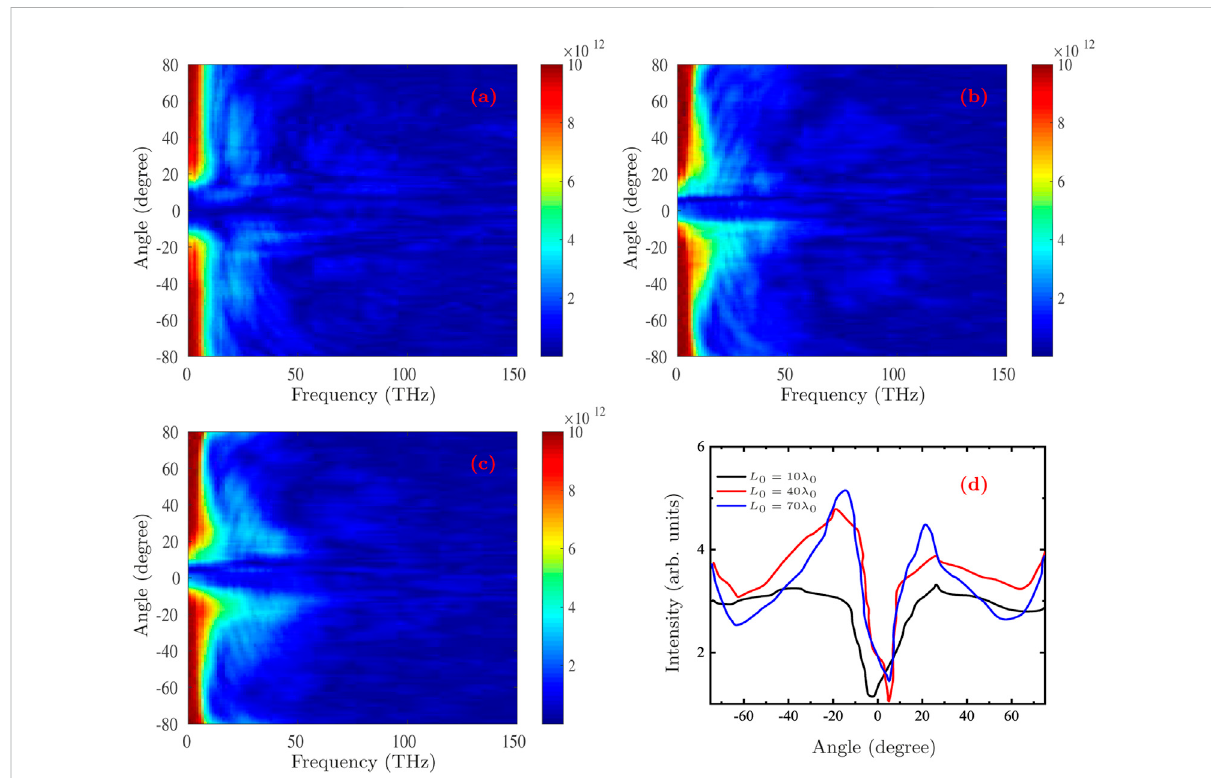
FIGURE 9 Theangular-spectradistributionoftheTHzradiationfordifferentlengthoftheTarget-Iwith L 0 =10 λ 0 (A) , L 0 =40 λ 0 (B) ,and L 0 =70 λ 0 (C) when λ d 0 = 4.0 0 . (D) The corresponding cumulatively summed angular-spectra distribution of THz